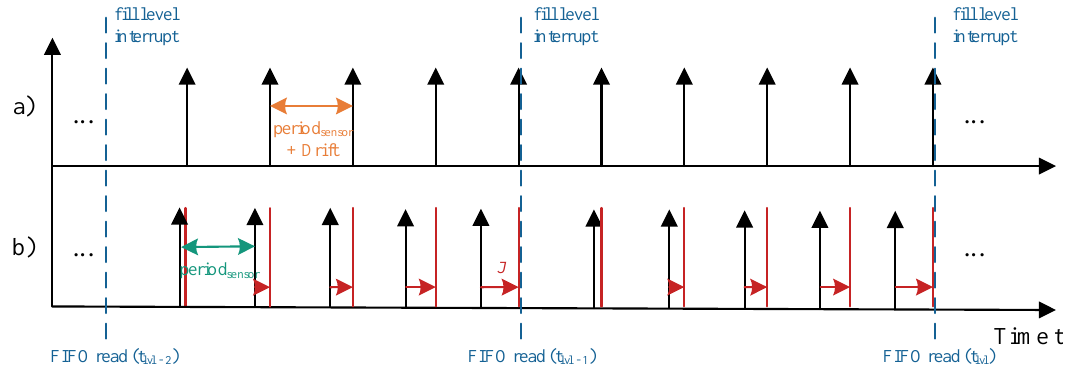
Figure 4. Exemplary result of basic time stamp reconstruction algorithm, where ( a ) represents the real samplings affected by a frequency deviation (drift) and ( b ) shows the reconstructed sampling times, highlighting the resulting Jitter J